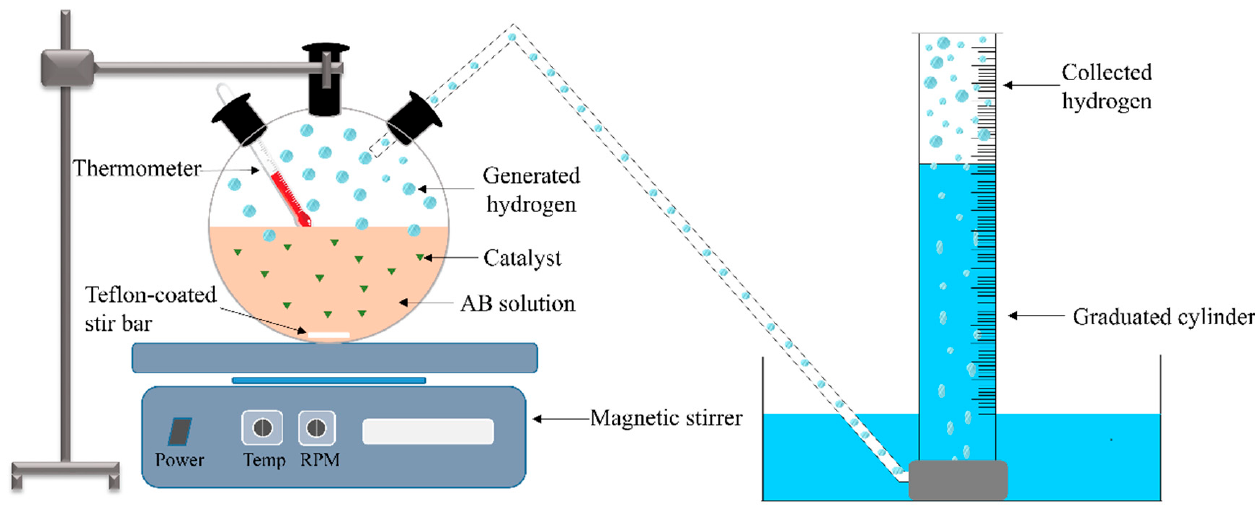
Figure 6. Schematic of batch reactor for testing the performance of electrospun catalysts for AB hydrolysis.